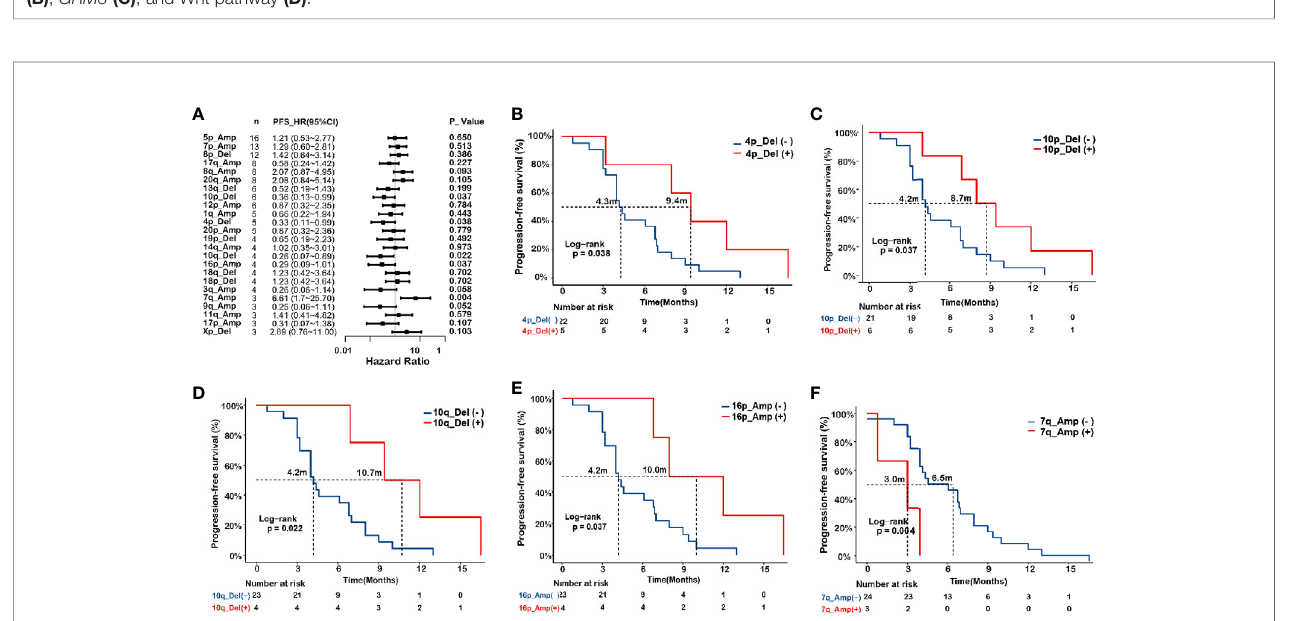
FIGURE 5 | Associations of arm level changes with EGFR-TKI outcome in EGFR -mutant squamous cell carcinoma (SCC). (A) Forest plot presenting hazard ratios (HRs) of progression-free survival (PFS) comparing subgroups with and without speci fi c arm-level changes in EGFR -mutated lung squamous cell carcinoma (SCC). (B – F) Kaplan-Meier curves of progression-free survival (PFS) in EGFR -mutated SCC in terms of arm-level changes on 4p_Del (B) , 10p_Del (C) , 10q_Del (D) , and 16p_Amp (E) , 7q_Amp (F) . Del, deletion; Amp, ampli fi